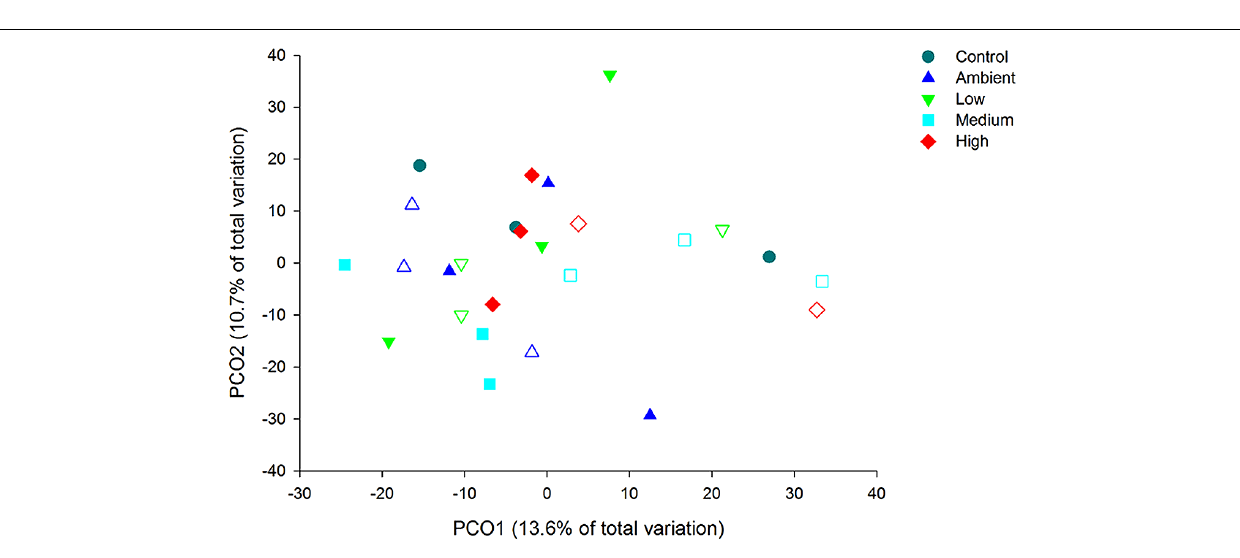
FIGURE 5 | Principal coordinate analysis (PCO) of the OTUs from the DNA-derived samples. Control samples are from day 0, solid symbols represent day 2 samples and open symbols represent day 7